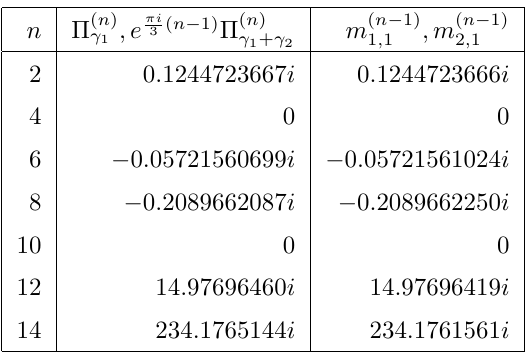
Table 1. Π ( n ) γ and m ( n − 1) for the third order ODE with p ( x ) = x 2 − 1 . a, 1